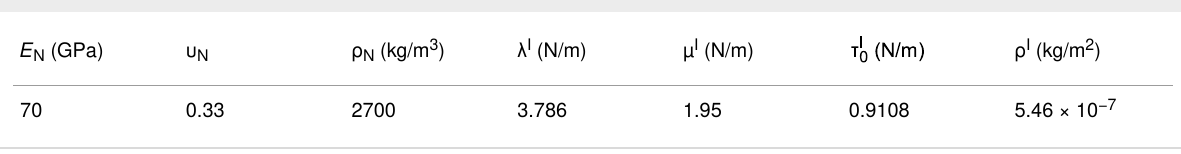
Table 2: Surface and bulk properties of Al nanoshell.